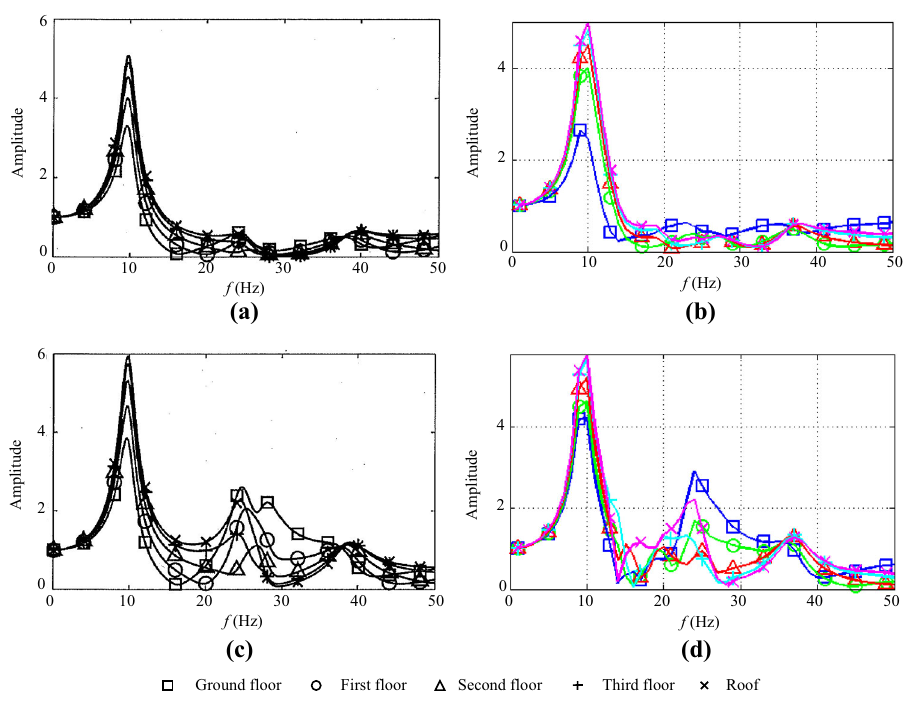
Fig. 9 Soil–building transfer functions of a four-storey apartment building: a , b wall; c , d floors; a , c one-dimensional prediction model; b , d three-dimensional finite-element model